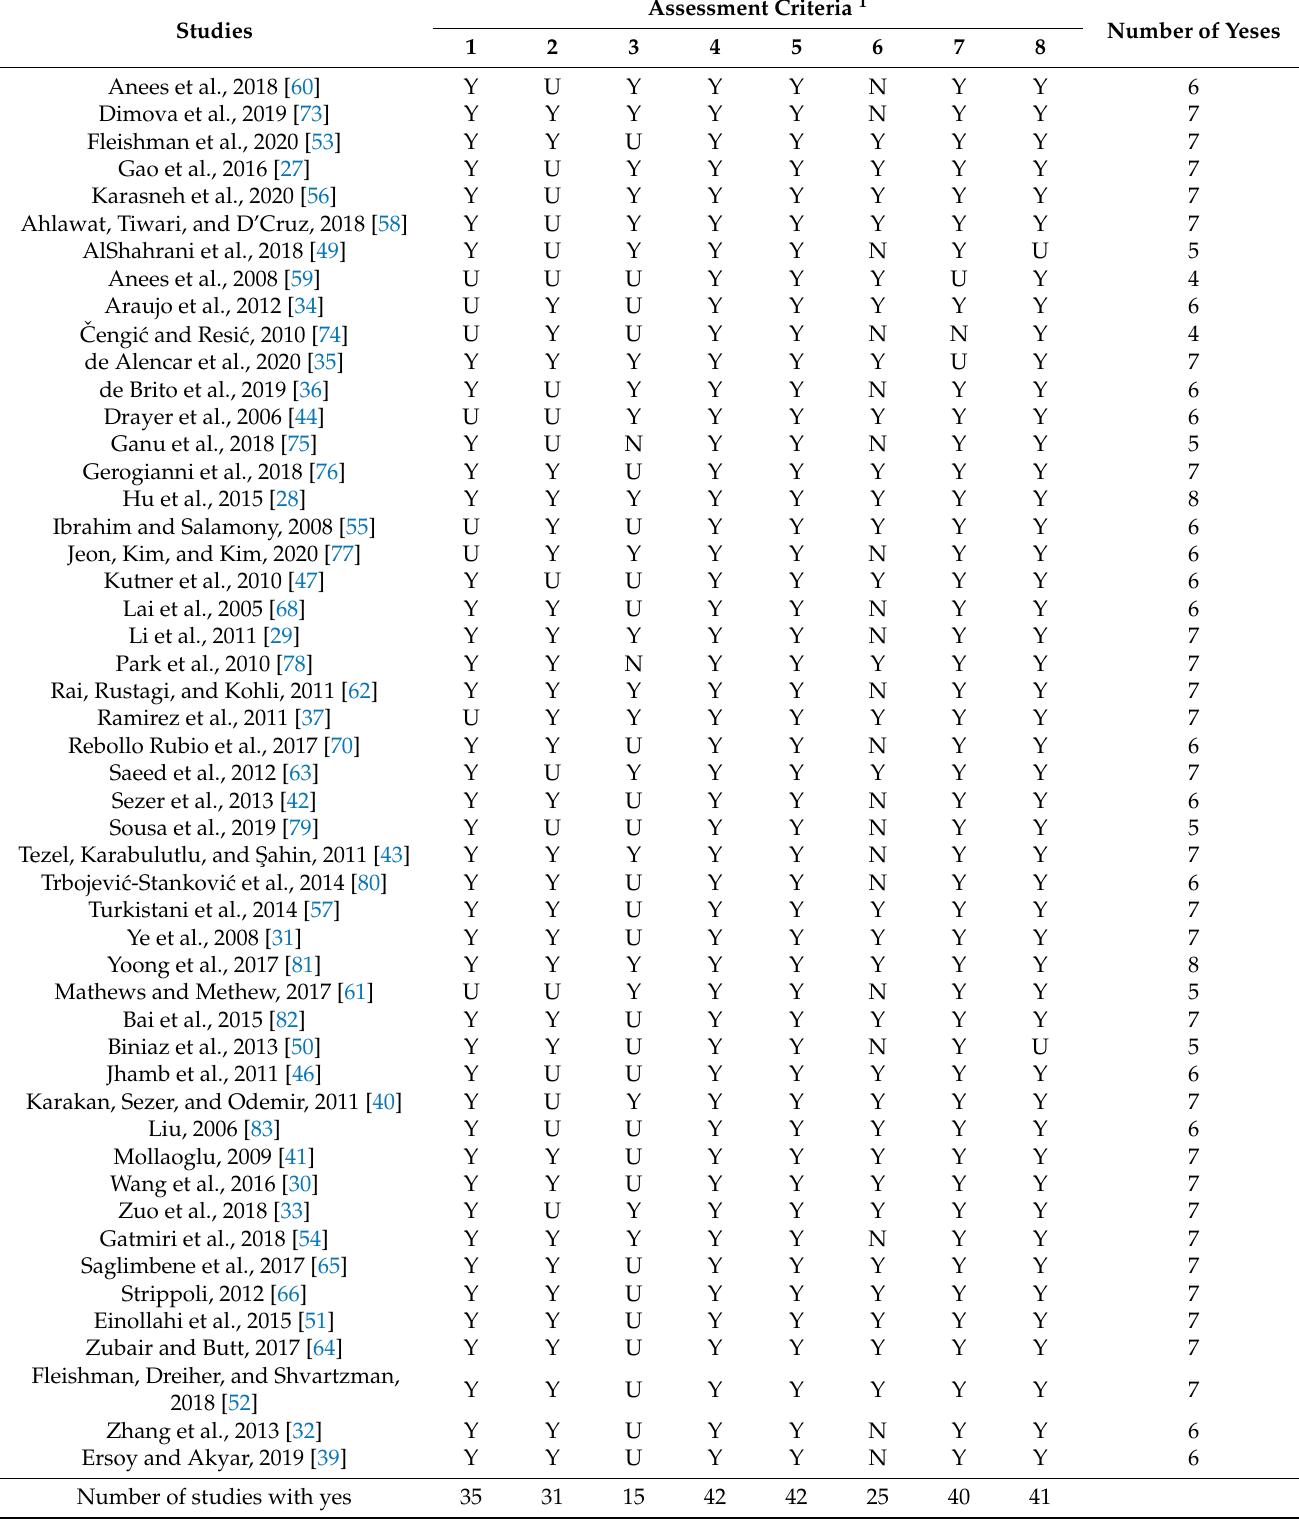
Table 1. Methodological quality of cross-sectional